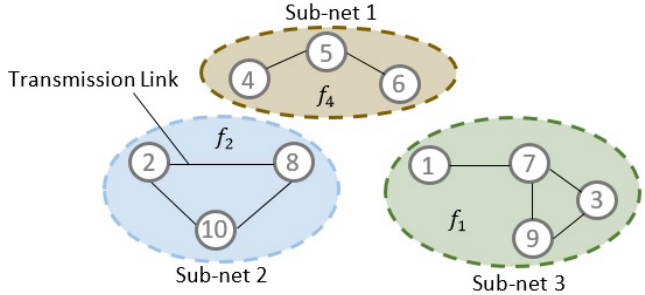
Figure 5. Sub-nets formation and frequency selection for data